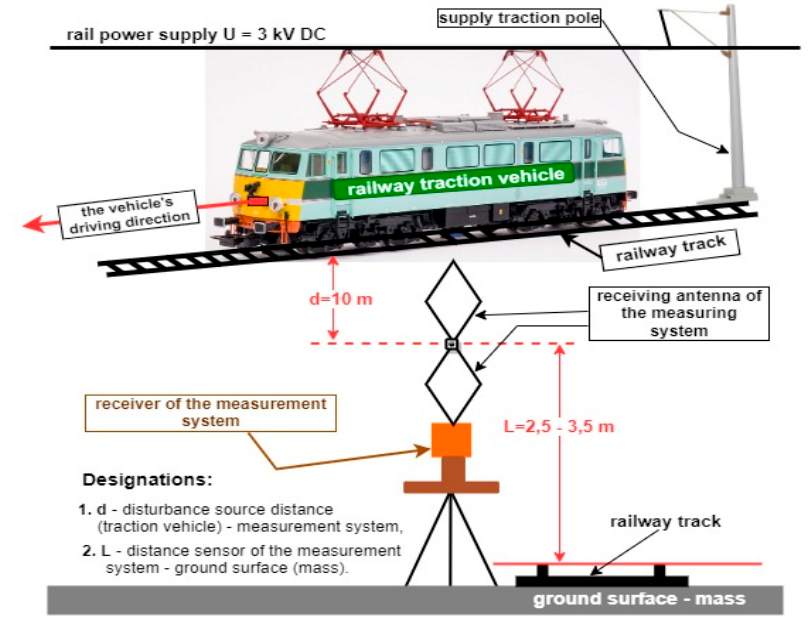
Figure 5. Measurement of radiated interference emission in the 150 kHz ÷ 30 MHz frequency band using a loop antenna.